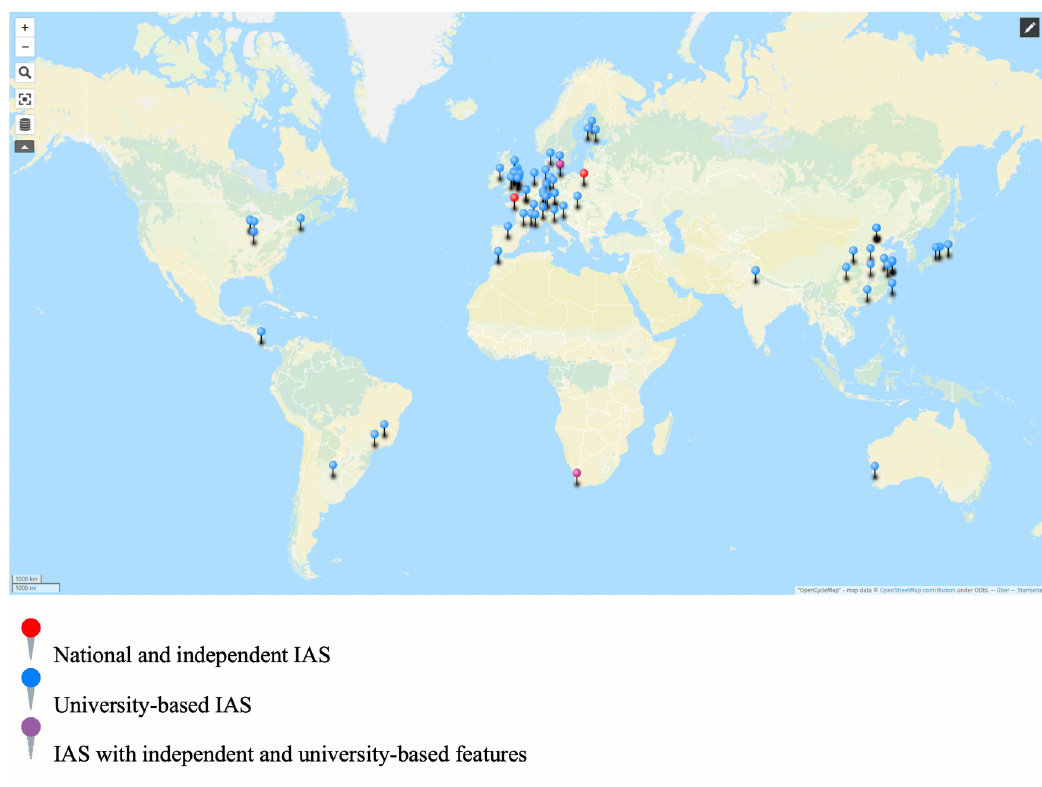
Fig. 3. Generation of the University-Based IAS (since